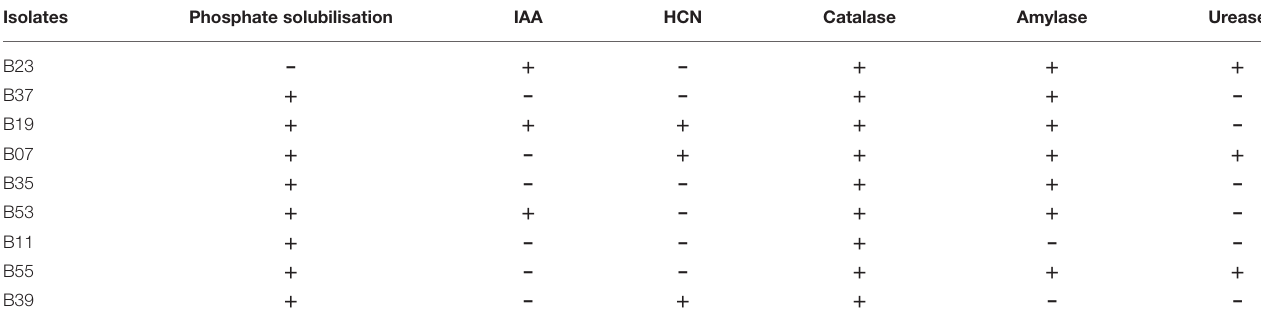
TABLE 2 | In vitro growth promotion assay and biochemical tests.